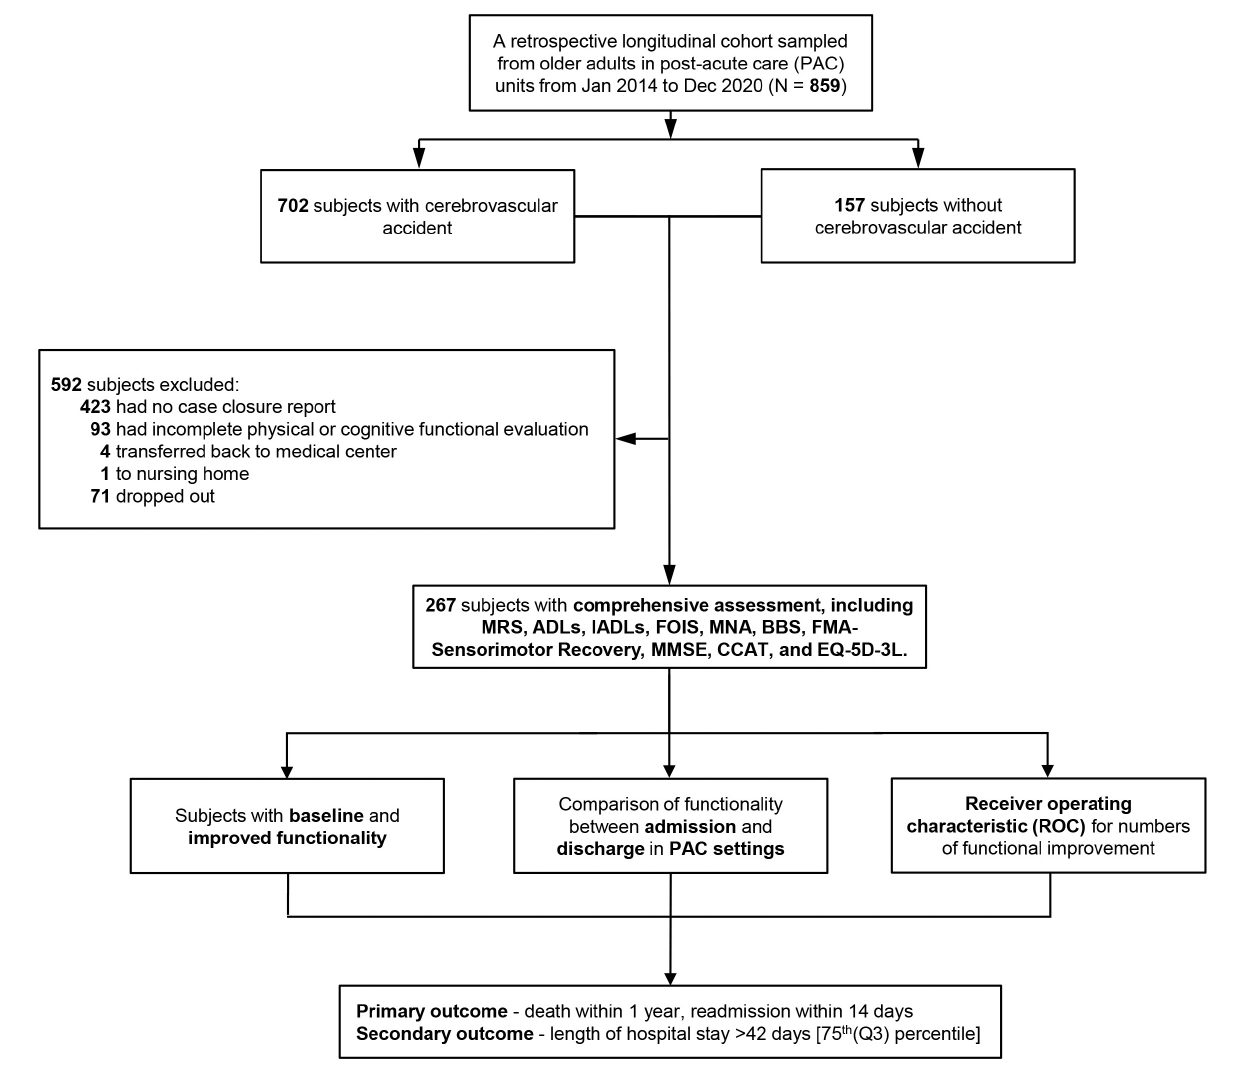
FIGURE 2 | Flowchart of patient selection. MRS, Modified Rankin Scale; ADLs, activities of daily living; IADLs, instrumental activities of daily living; FOIS, Functional Oral Intake Scale; MNA, Mini-Nutritional Assessment; BBS, Berg Balance Scale; FMA, Fugl-Meyer Assessment; MMSE, Mini-Mental State Examination; CCAT, Concise Chinese Aphasia Test; EQ-5D-3L, 3-level 5-dimensional European Quality of Life questionnaire; PAC, post-acute